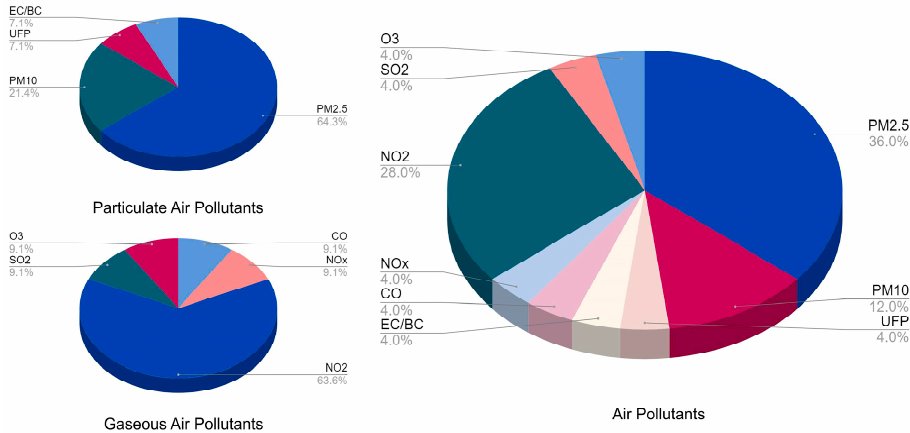
Figure 5. Outdoor Air Pollutants Distribution.